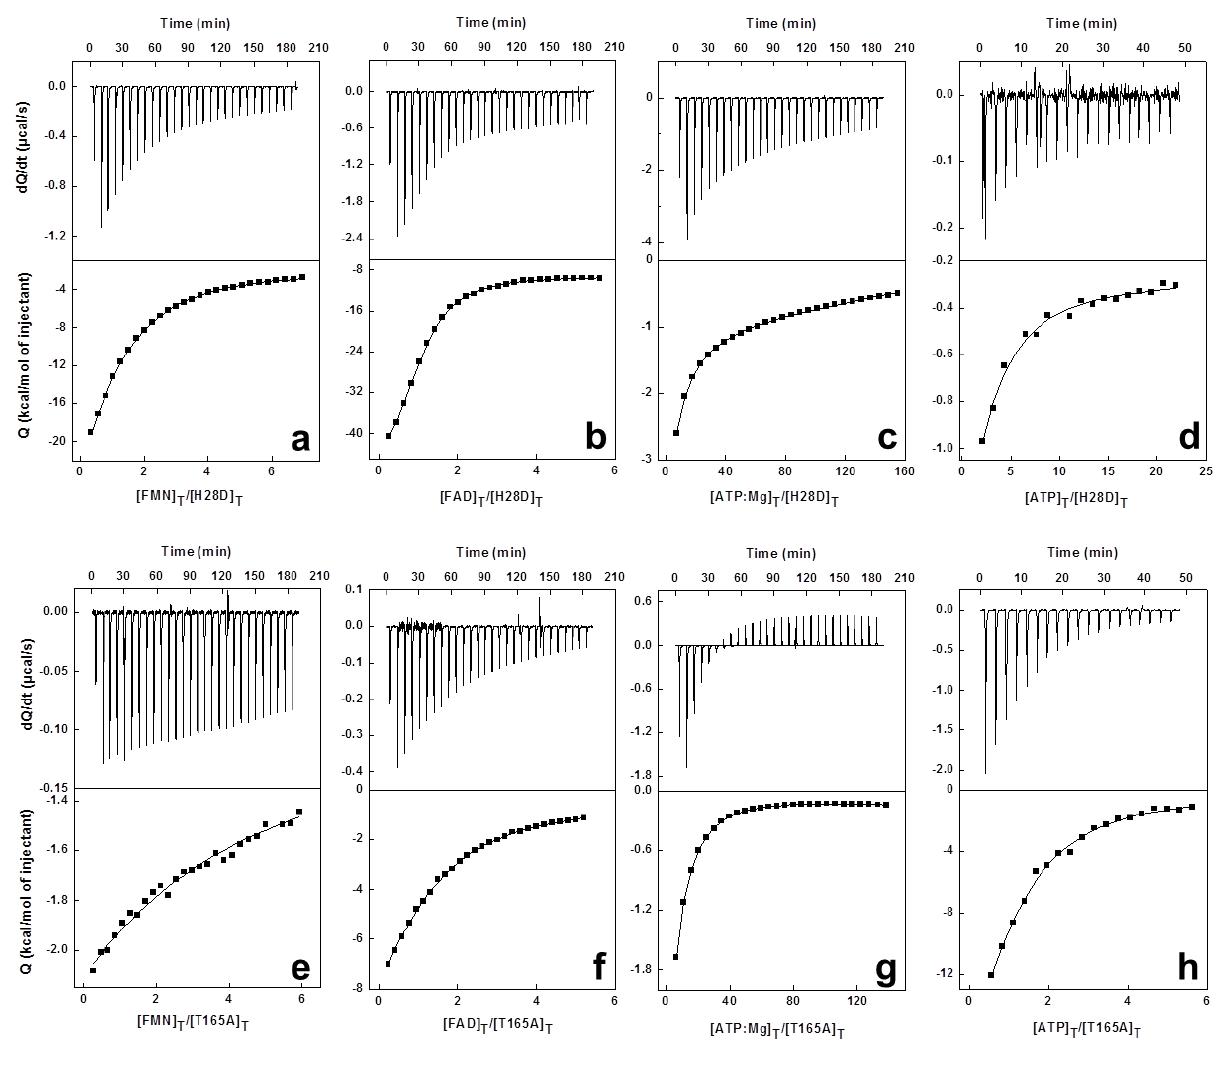
Figure S5. Calorimetric titration of H28D and T165A Ca FADS (~20 μM) with ( a – e ) FMN (200 μM), ( b – f ) FAD (200 μM), ( c – g ) ATP (5 mM) and ( d – h ) ATP (200 μM) in absence of MgCl . Upper panels show thermograms for the interaction and lower panels show the 2 corresponding binding isotherms with integrated heats. Except for (d and h) the experiments were carried out in 20 mM PIPES, 10 mM MgCl 2